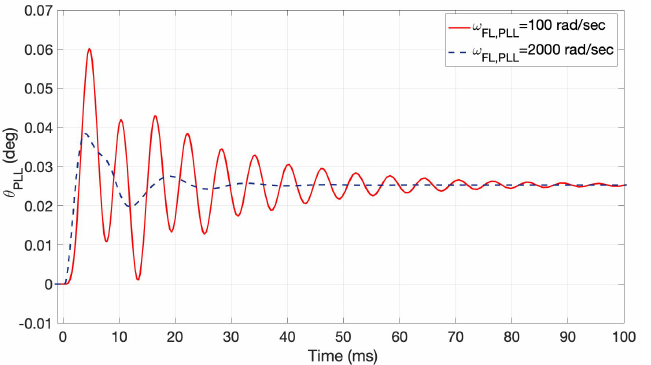
Figure 22. Time domain response of the θ PLL for AIC-PLL for step change in Z g = 1.7 for different values of the ω FL , PLL